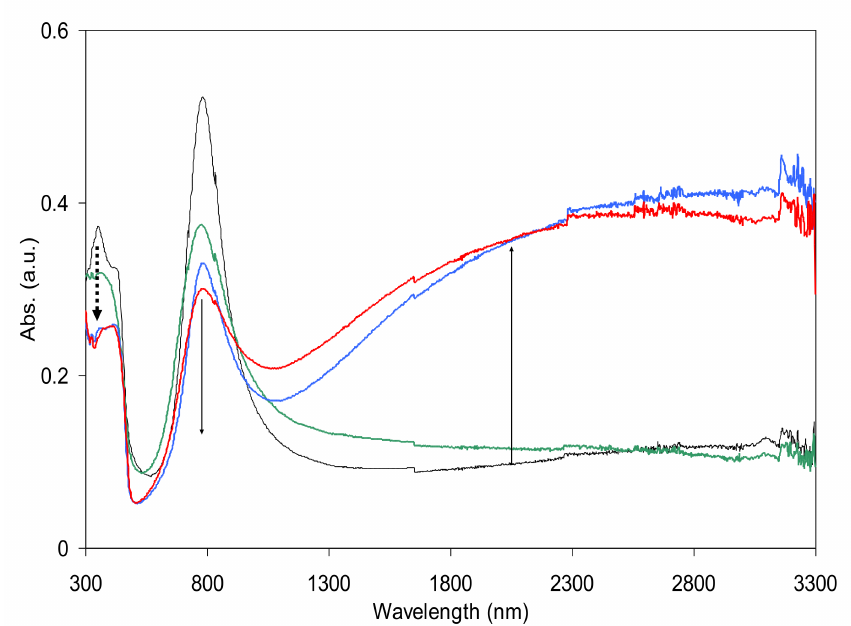
Figure 5. UV–Vis–NIR spectra of PANI-DNNSA films that were film doped with TSAm. The films were air-dried (black line), thermally treated after (green), before (blue), or before and after (red) doping with TSAm. Thermal treatment condition: 150 ◦ C, 30 min in